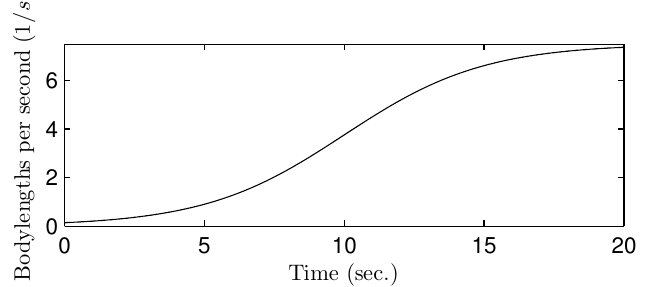
Figure 11. The speed graph with respect to the time used in the simulation.